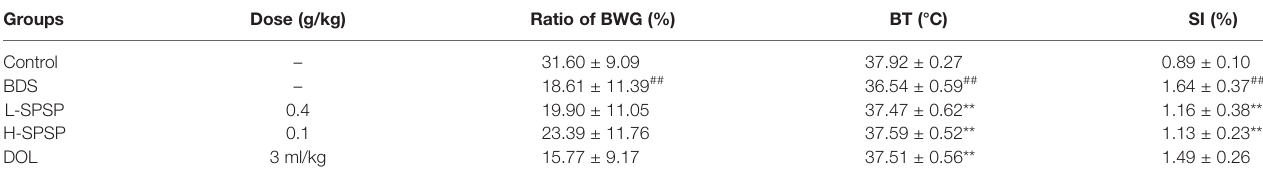
TABLE 1 | Effect of SPSP on ratio of BWG, BT and SI.